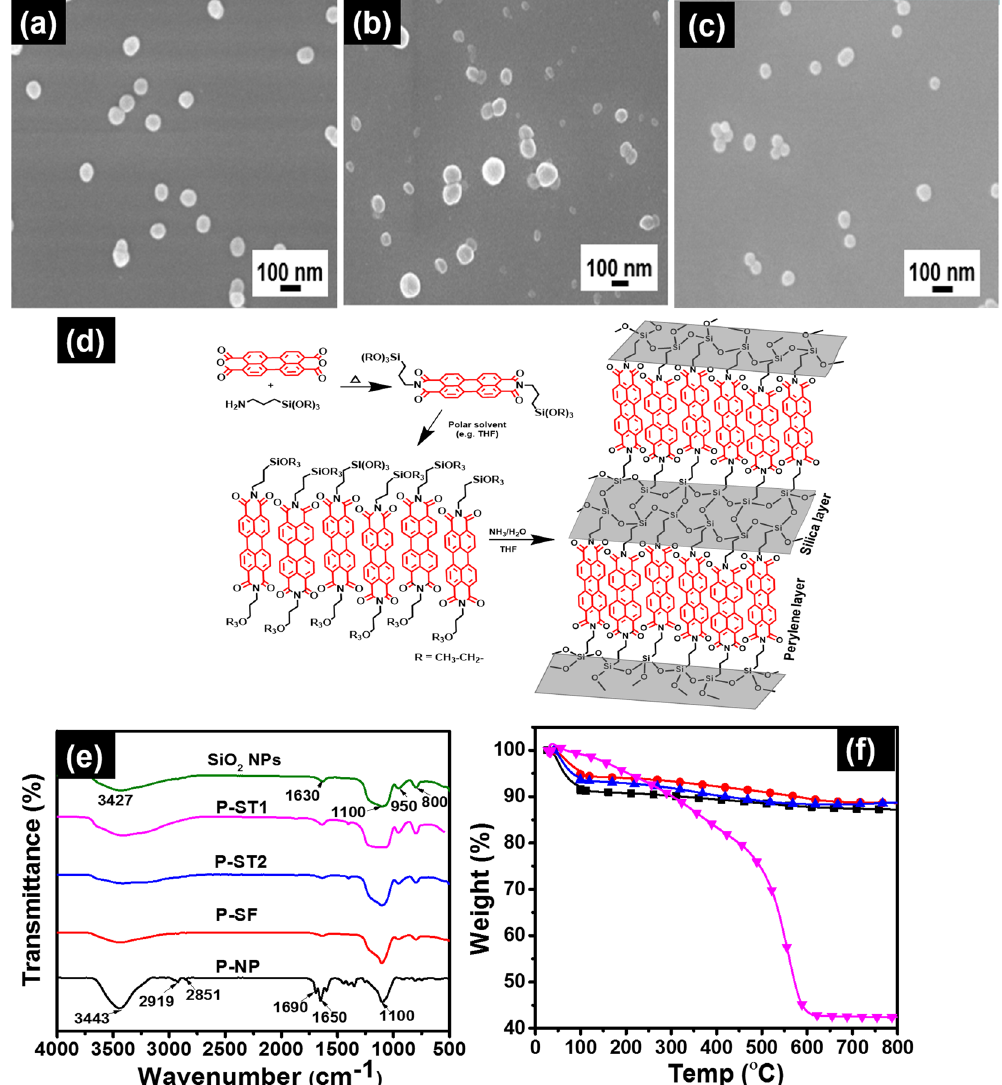
Figure 2. SEM morphologies of P-ST ( a ), P-NP ( b ) and P-SF ( c ). Polymerization of PDI-1 ( d ) to form perylene rich region and silica region. FTIR spectra ( e ) of unmodified silica NPs, P-ST1 , P-ST2 , P-SF and P-NP . TGA traces ( f ) of P-ST1 ( ■ ), P-ST2 ( ), P-SF ( ), and P-NP ( ) particles in